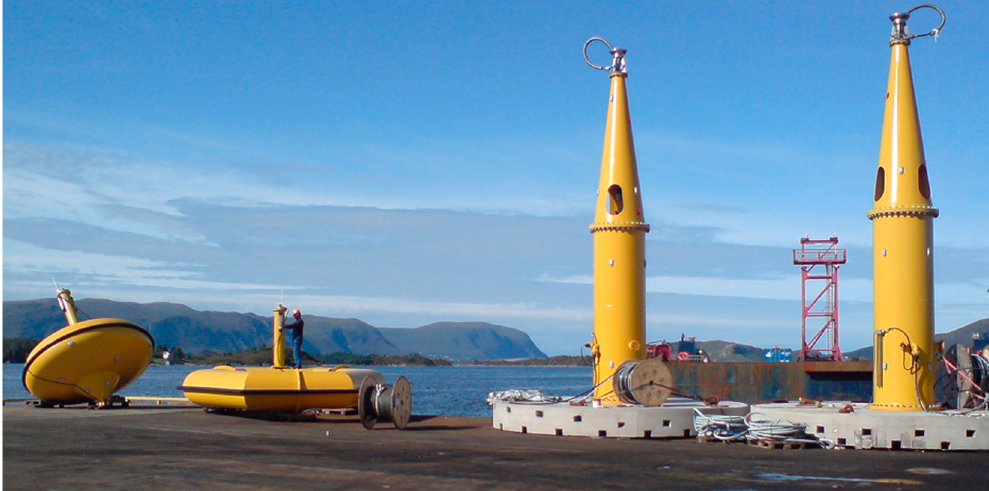
Figure 2. Photo of buoys and translators on the harbor before offshore deployment.